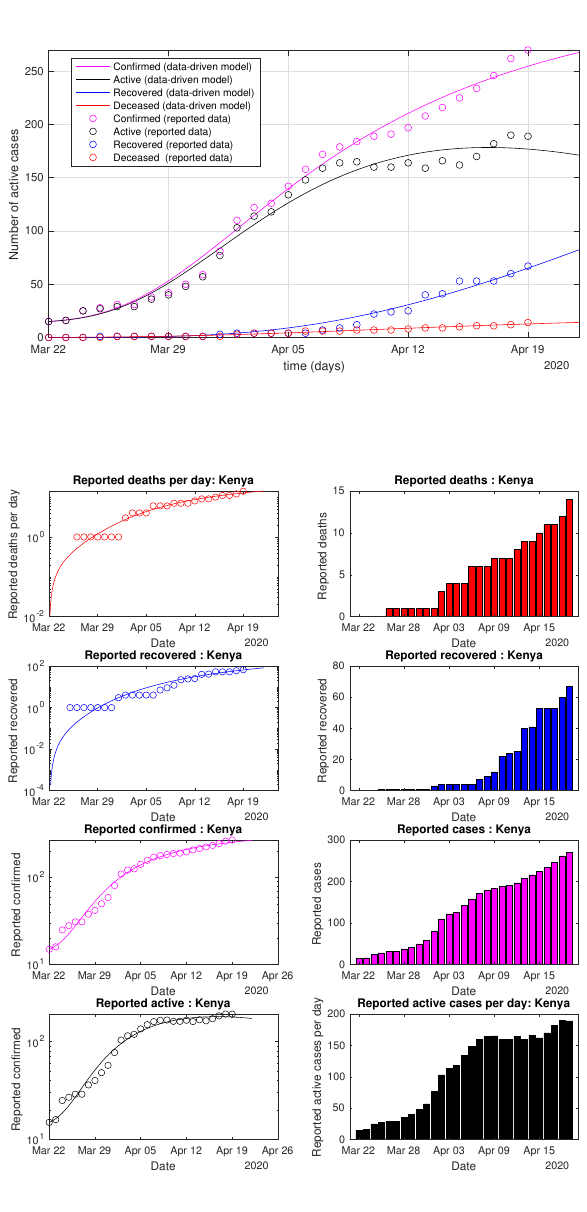
Figure 67. Kenya: data vs.